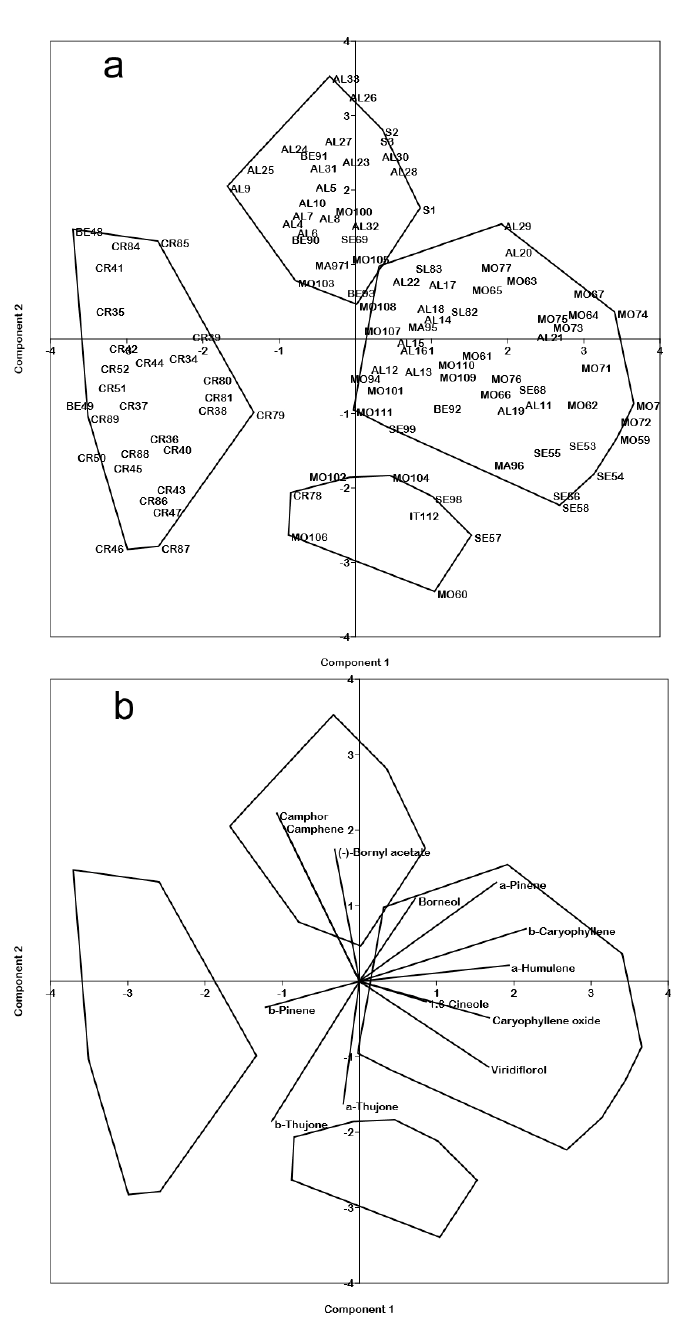
Figure 2. Principal component analysis (PCA) scatterplot of the first (31.23% of variability) and second (18.29%) components; ( a ) scatterplots of cases (acronyms follow the Supplementary Materials Table S1) and ( b ) scatterplot of essential oils (EOs).